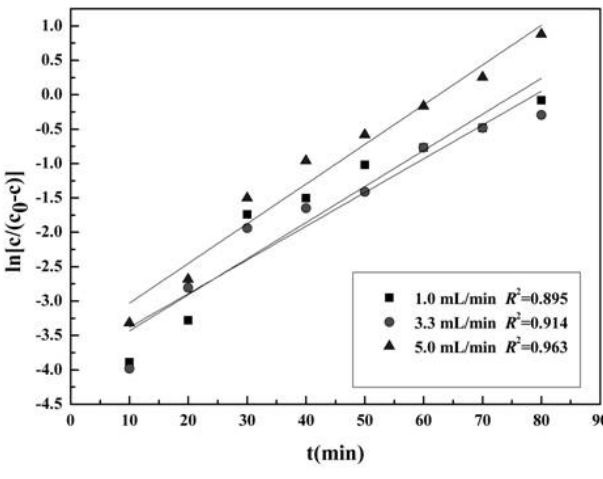
Figure 7. Dynamic adsorption curves of 1-DNJ with 732 resins under different flow